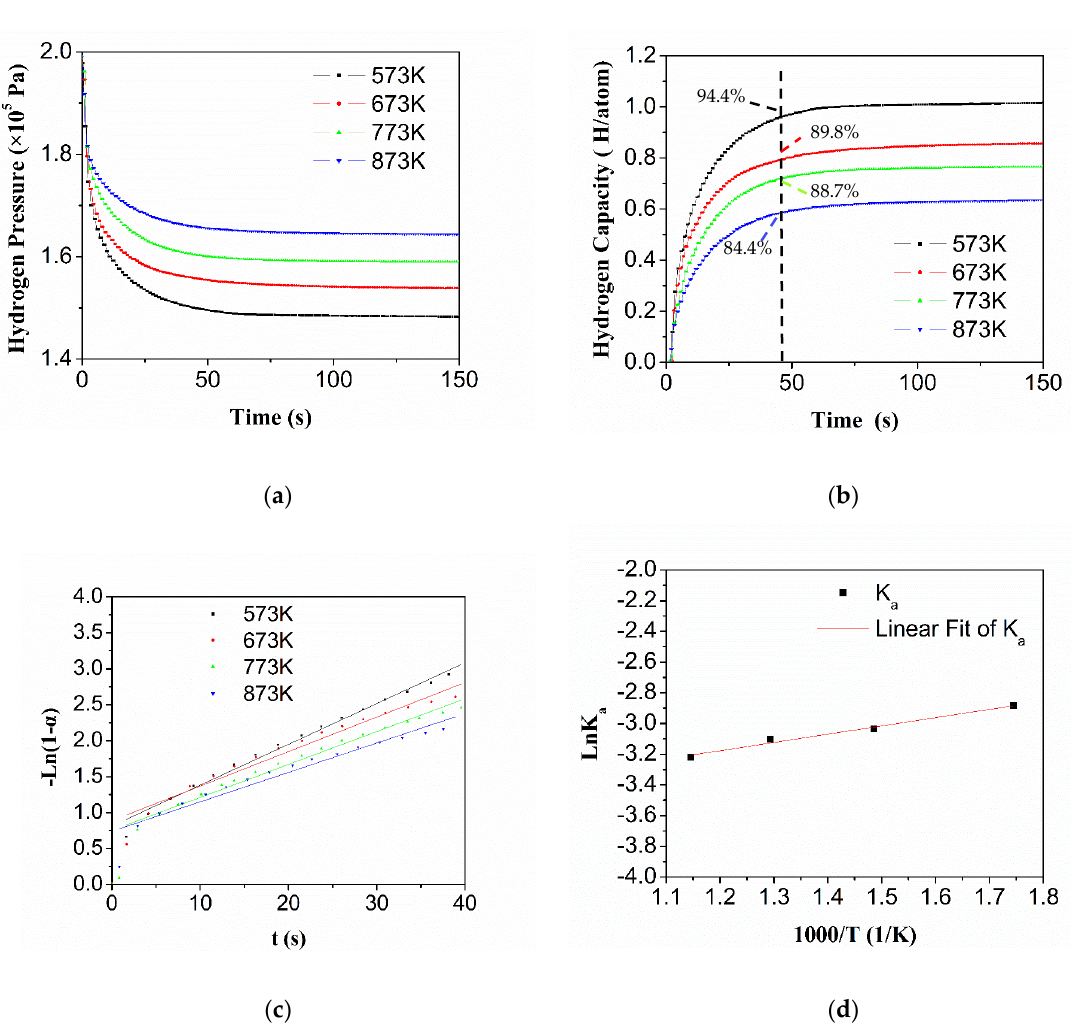
( c ) ( d ) Figure 5. The hydrogen absorption kinetics curves of Ti 0.20 Zr 0.20 Hf 0.20 Nb 0.40 HEA at 573 K, 673 K, 773 K, 873 K (initial hydrogen pressure: 2 × 10 5 Pa): ( a ) hydrogen capacity; ( b ) hydrogen pressure; ( c ) the hydrogen absorption kinetic analysis curves of Ti 0.20 Zr 0.20 Hf 0.20 Nb 0.40 HEA; ( d ) the relationship between the activation energy and temperature of the hydrogen absorption reaction. Table 3. The hydrogen absorption equilibrium pressure, equilibrium hydrogen storage capacity and hydrogen absorption